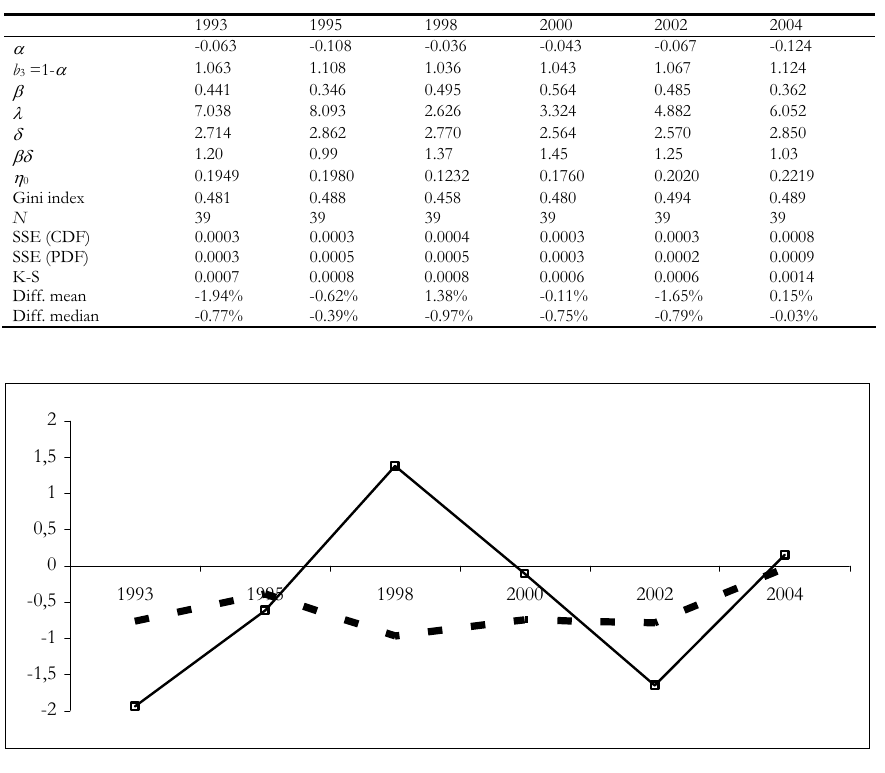
Figure 1 – Dagum model for human capital distribution in Italy from 1993 to 2004. Per cent differ- ences between observed and estimated values for the mean (continuous line) and the median (dotted